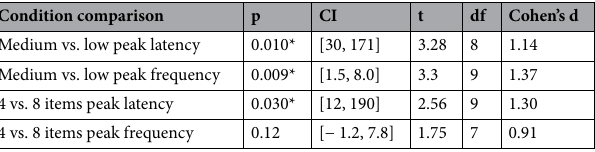
Table 3. Comparisons between PLD peaks (two-tailed paired t-tests). Same conventions as in Table 2.